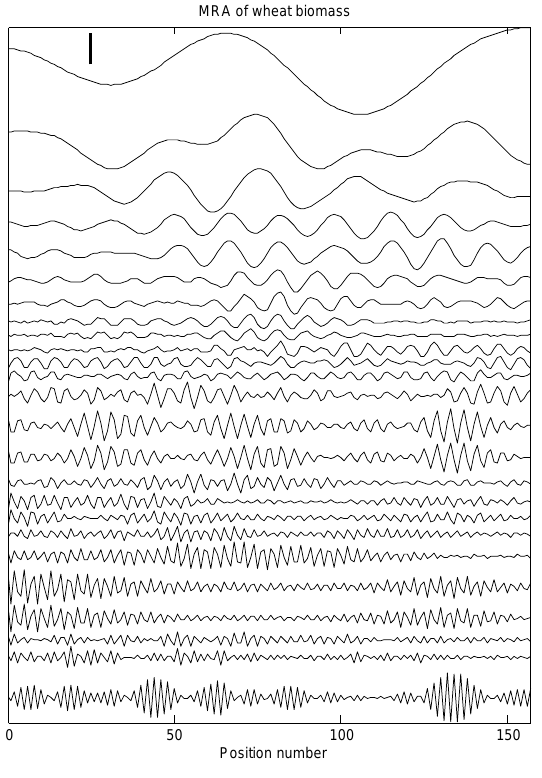
Fig. 6. Multiresolution analyses of wheat biomass decomposed on the “best basis”. The components are stacked from highest fre- quency at the bottom to lowest frequency at the top (residual once other components are removed). The scale-bar is shown by the ver- tical bar on the plot and this is of length 50kg ha − 1 .